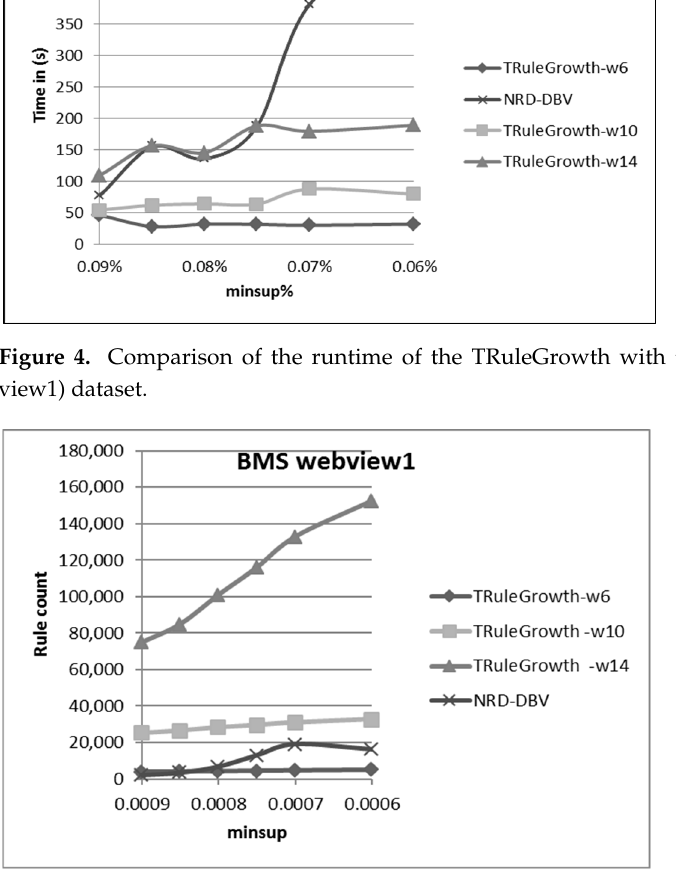
Figure 5. Comparison between the No. of rules generated for the TRuleGrowth and the NRD-DBV for (BMS webview1) dataset.